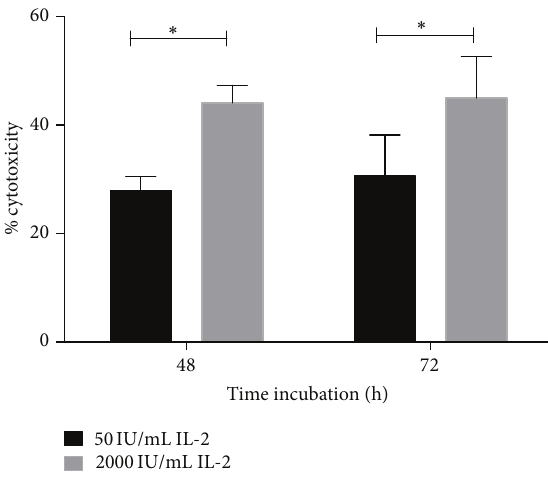
Figure 1: Human purified NK cells incubated with IL-2 increase cytotoxic activity. NK cells were incubated for 48 or 72 h in the presence of 50 IU/mL (control) (black bar) or with 2000 IU/mL to induce LAK activity (grey bar). Cytotoxic activity was measured in a 4h 51 Cr release assay using Daudi cells as target cells and an effector : target ratio of 1:1. Results are mean ± SE from at least 8 independent experiments ( ∗ 𝑝 < 0.05